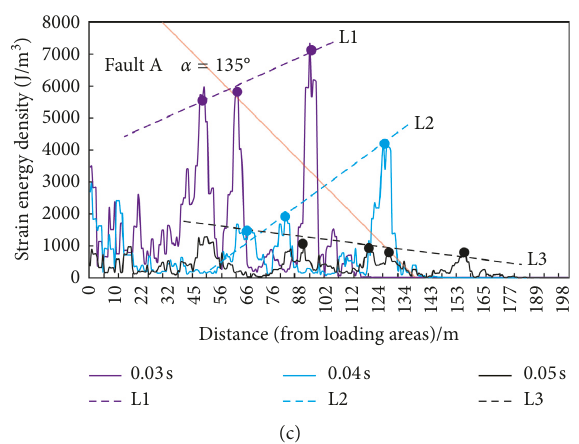
Figure 5: The strain energy density along the horizontal middle line of the cross section in the middle of the model box (as shown in Figures 2–4). The horizontal axis represents the distance from the blast loading area to the current position. The purple, blue, and black curves represent the distribution and evolution of the strain energy density at 0.03s, 0.04s, and 0.05s, respectively. The preexisting fault is indicated with red solid line, the dip angle of fault A is set to α � 60 ° , 90 ° , and 135 ° , respectively. Dotted L1, L2, and L3 is used to indicate the evolution of the major pulses of the strain energy density with time. (a) Case D60. (b) Case D90. (c) Case